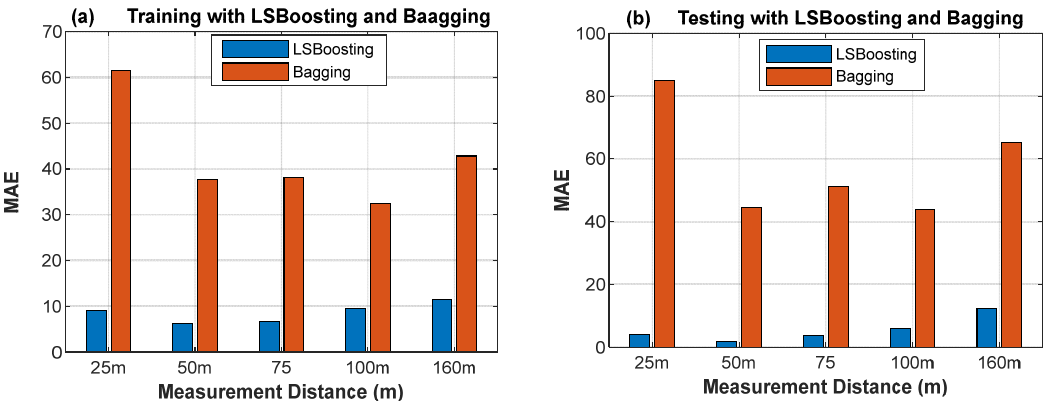
Figure 18. MAE values attained in engaging the LS-Boost and bagging algorithms in the random forest model in adaptively testing the throughput quality at different distances. Table 6. Throughput data training accuracy using LS-Boosting and bagging.